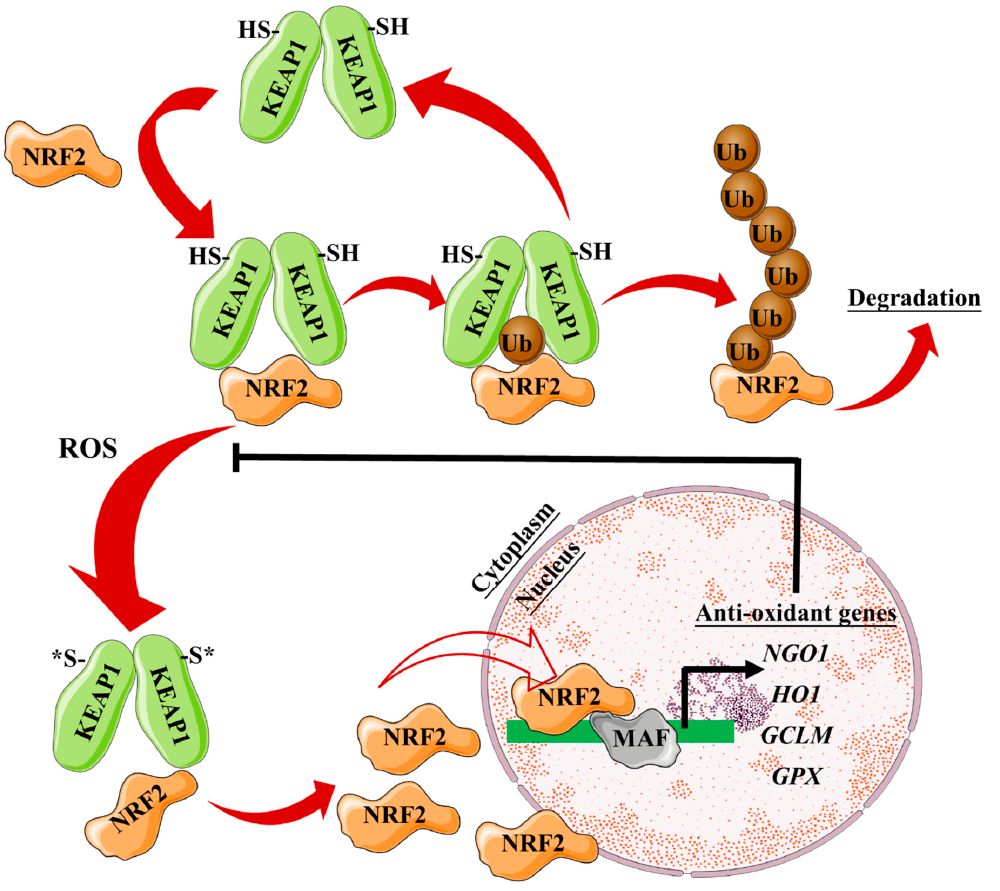
Figure 4. Overview of the ROS/Nrf2-axis and its anti-oxidant effect. Kelch-like ECH-associated protein (KEAP1) homodimers promote NRF2 ubiquitylation leading to proteasomal degradation. KEAP1 is then recycled to bind newly synthesized NRF2. Oxidative stress drives oxidation of key cysteine residues on KEAP1, preventing NRF2 ubiquitylation. NRF2 can thus accumulate and translocate to the nucleus, where it dimerizes with one of the small MAF proteins to promote the transcription of anti-oxidant genes. GCLM, glutamatecysteine ligase modi fi er subunit; GPX, glutathione peroxidase; KEAP1, Kelch-like ECH-associated protein 1; MAF, musculoaponeurotic fi brosarcoma; NRF2, nuclear factor (erythroid-derived 2)-like 2.